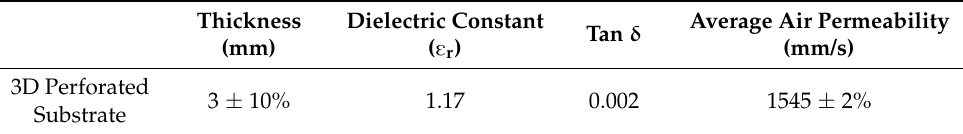
Table 2. Properties of the 3D perforated dielectric